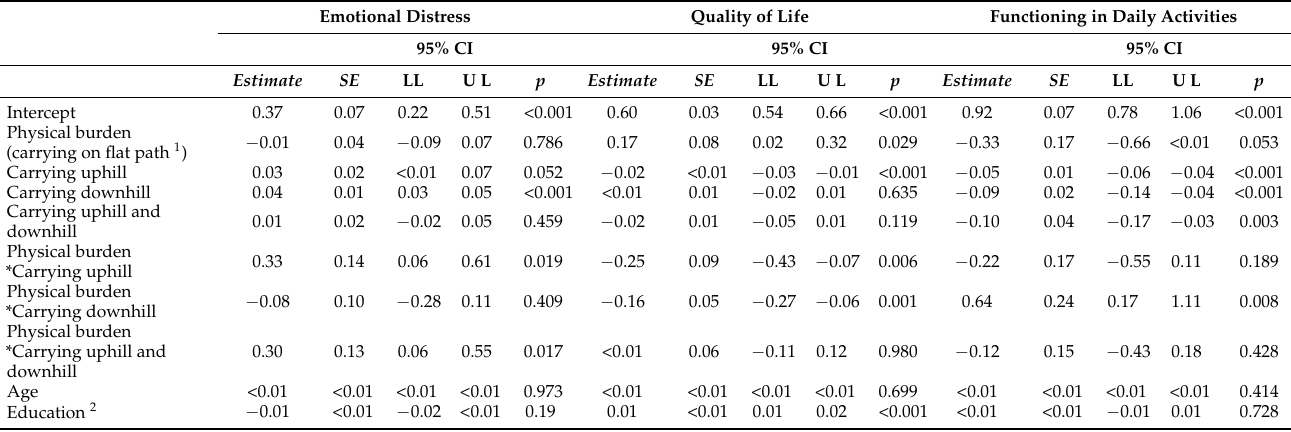
Table 3. Generalized estimating equations of objective physical burden of carrying water and psychosocial well-being (emotional distress, quality of life, and daily functioning) and its moderation by the